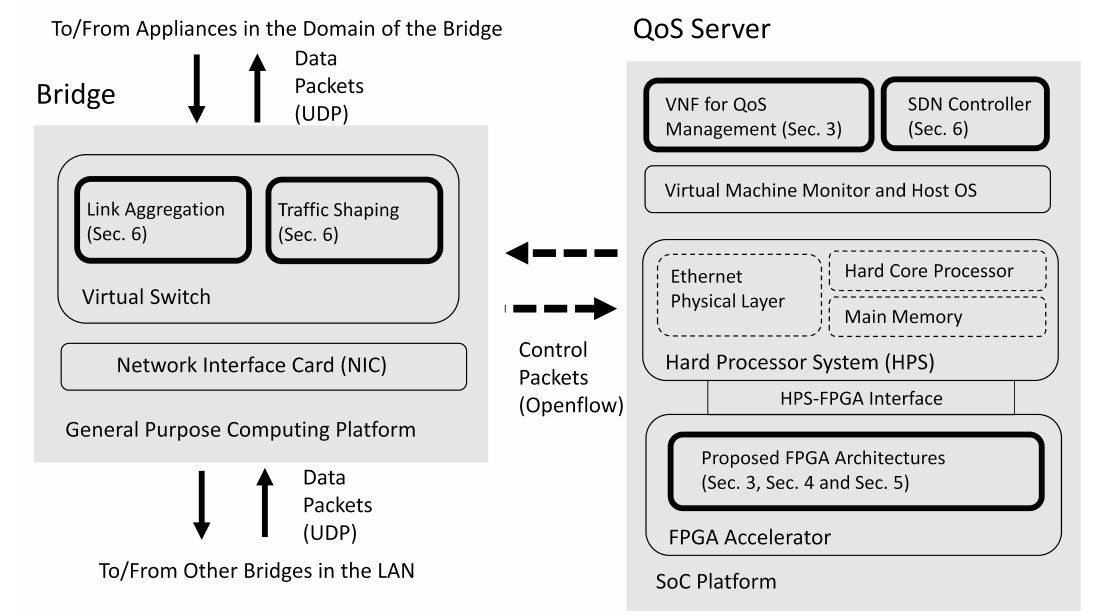
Figure 1. The block diagrams of a bridge and a QoS server in the virtual LAN. The bridge is a general purpose computer with a virtual switch. The QoS server is an SoC consisting of FPGA and HPS. In this study, the highlighted blocks are